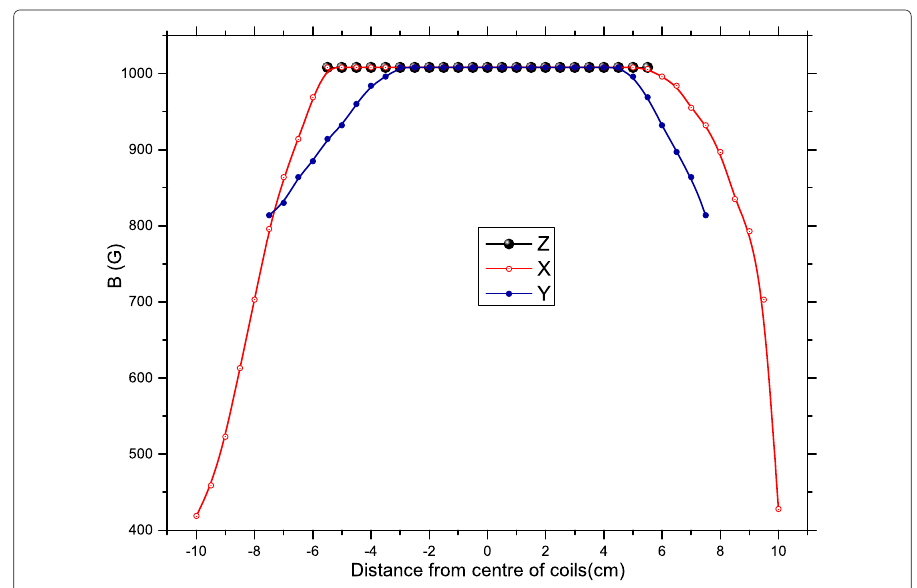
Fig. 5 Homogeneity of magnetic field along X , Y and Z